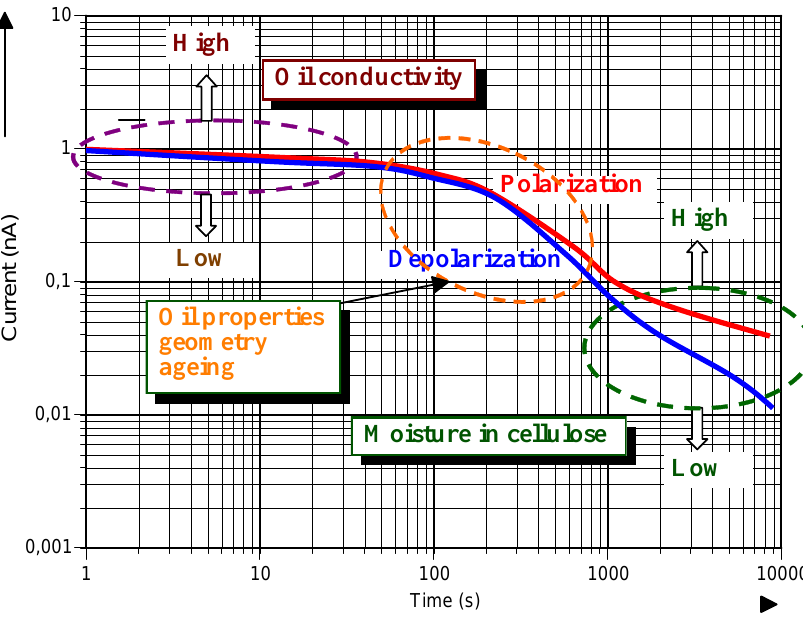
Figure 2. Interpretation of PDC measurement data.